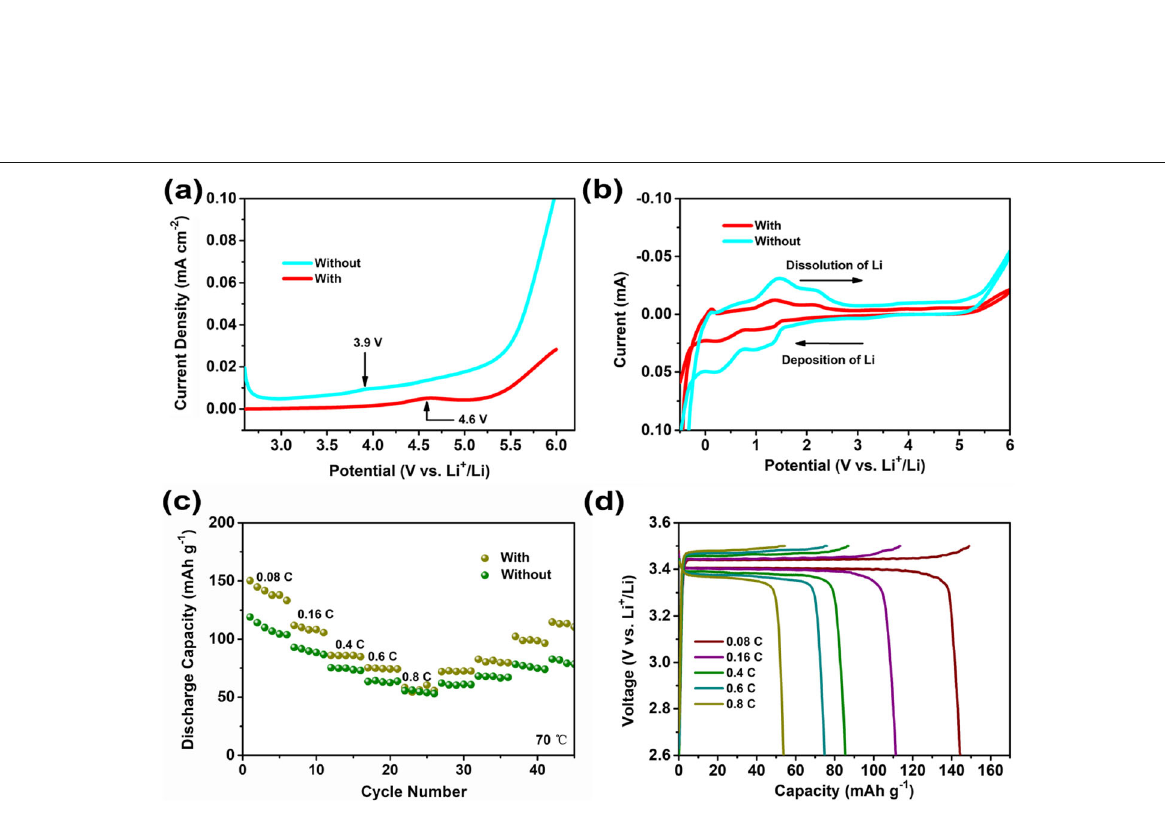
Fig. 3 The electrochemical performance of SPEs: LSV profiles ( a ), cycling performance ( b ), rate performance ( c ), and voltage profiles of SPEs after montmorillonite ( d